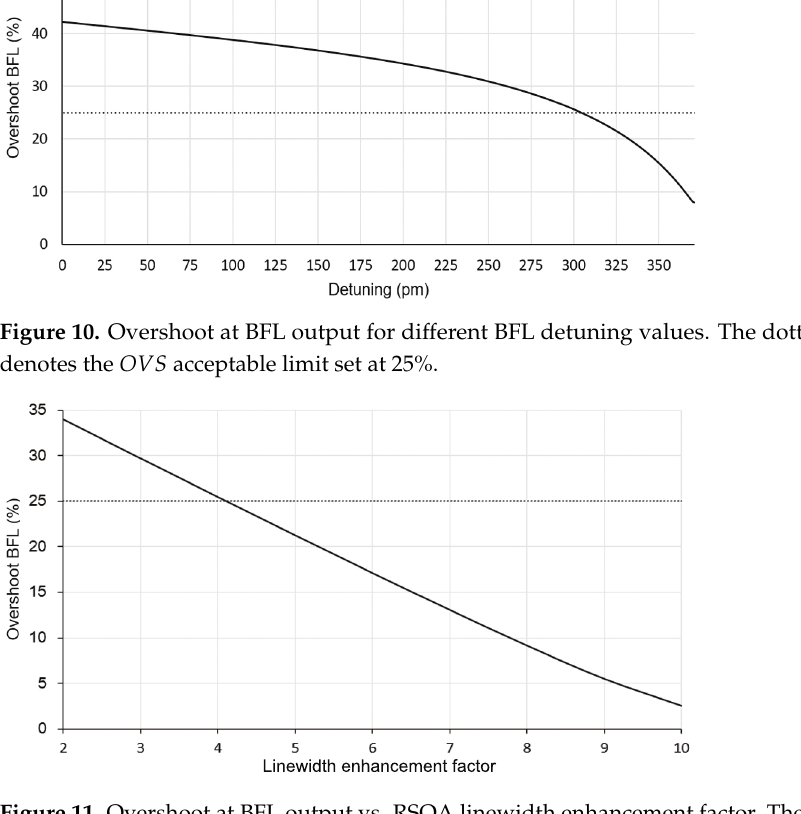
Figure 11. Overshoot at BFL output vs. RSOA linewidth enhancement factor. The dotted horizontal line denotes the OVS acceptable limit set at